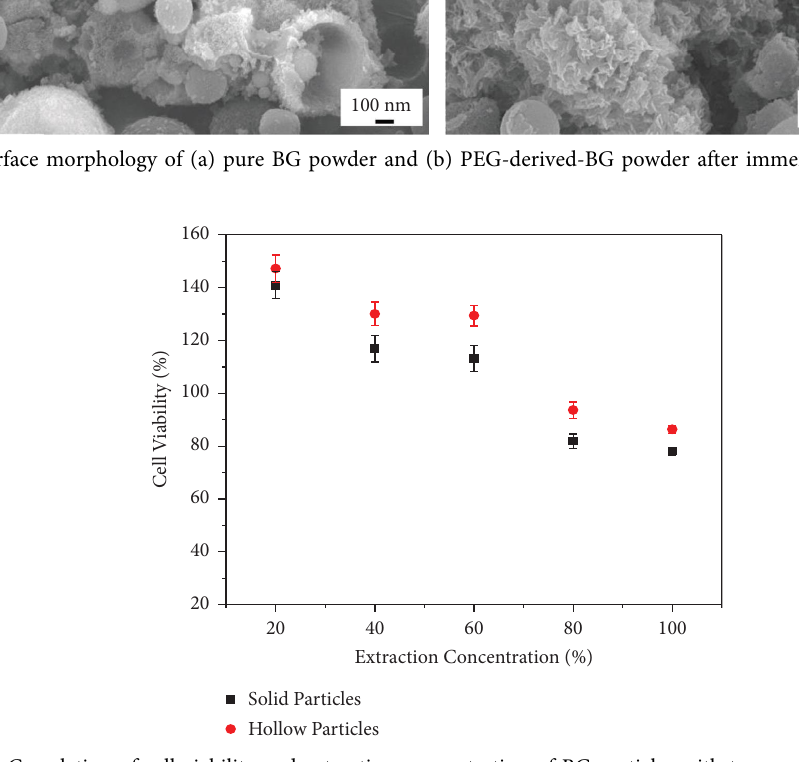
Figure 6: Correlation of cell viability and extraction concentration of BG particles with two particle morphology. Table 2: Statistical test of cell viability with p values for solid and hollow particles at a diferent extraction concentration. % Extraction concentration Solid